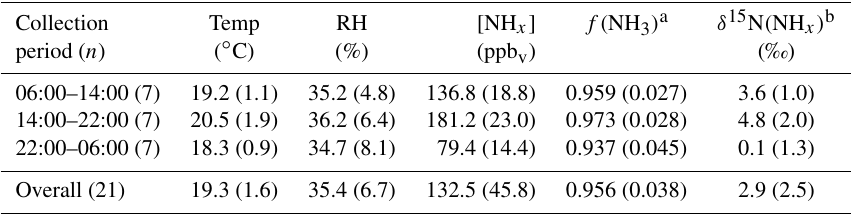
Table 3. Summary of the Shenyang, China, tunnel data including temperature (Temp), relative humidity (RH), [ NH x ] , f ( NH 3 ) , [ NH 3 ] , and δ 15 N ( NH x ) . Data are reported as x( ± 1 σ ) for each collection period and the overall monitoring period during summer and winter. The number of collections made during each collection period ( n ) is also indicated.